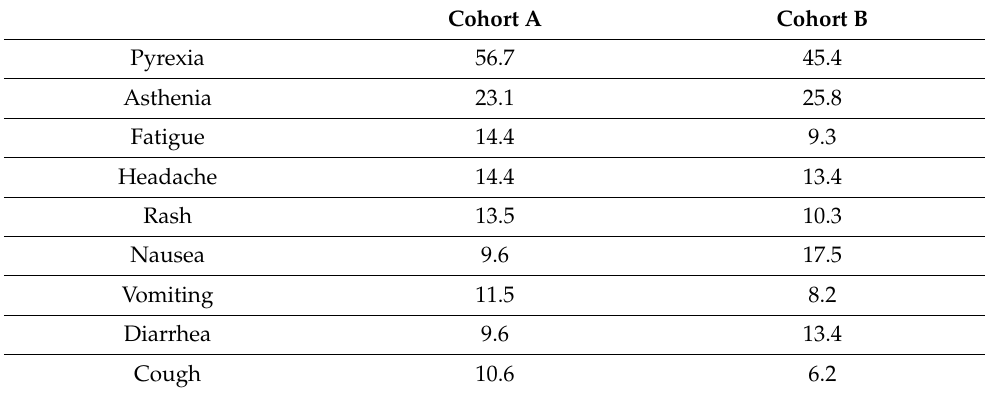
Table 2. Adverse reactions. Data were reported as